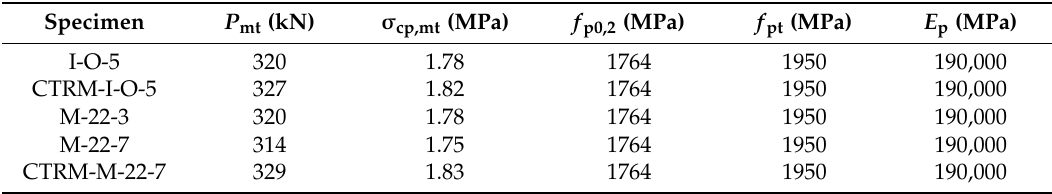
Table 6. Pre-stressing values and properties of tendons.